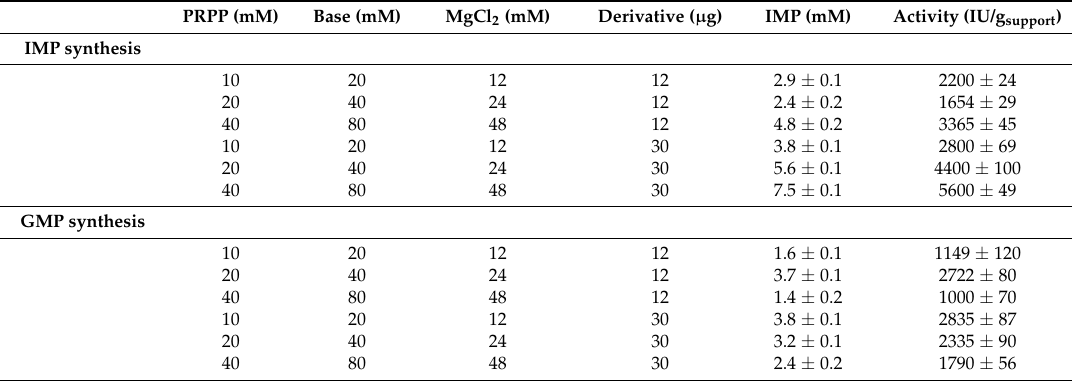
Table 3. Enzymatic production of dietary nucleotides catalyzed by M Tt